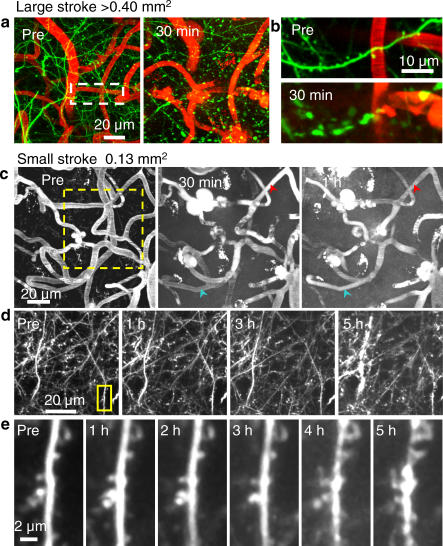
Small Strokes Escape Immediate Damage to Dendrites(A) Images from a YFP mouse showing the vasculature (red) and dendrites (green) (maximal intensity projection of first 100 μm of the cortex) before and 30 min after photoactivation (1 min) of RB in an animal that resulted in severe ischemia and dendritic damage (>0.40 mm2 surrounding area with clotted vessels). Vessels labeled with TR-dextran were all clotted in the imaged region.(B) A higher magnification view of the white-boxed region in (A) before and 30 min after photothrombosis.(C) Dorsal view of the microvasculature (maximal intensity projection) from 100 planar scans acquired every 1 μm before, 30 min, and 1 h after photoactivation of RB in a different animal with a small stroke (0.13 mm2 of cortical surface with clotted vessels) only affecting a subset of vessels. Flowing vessels can be assessed by the streaked images of vessels reflecting scanning of moving RBCs. The percentage of clotted vessels was 34% and 32% for 30 min and 1 h, respectively. The red arrowhead shows a capillary that was clotted at 30 min and was reperfused at 1 h, and the blue arrowheads mark a capillary that was flowing at 30 min but was clotted at 1 h.(D) Z-projection of dendrites from the yellow-boxed region in (C) showing relatively slow degeneration of dendritic structure for this relatively small stroke with partial reduction in blood flow.(E) Magnified view (yellow box in [D]) showing spine structural changes.